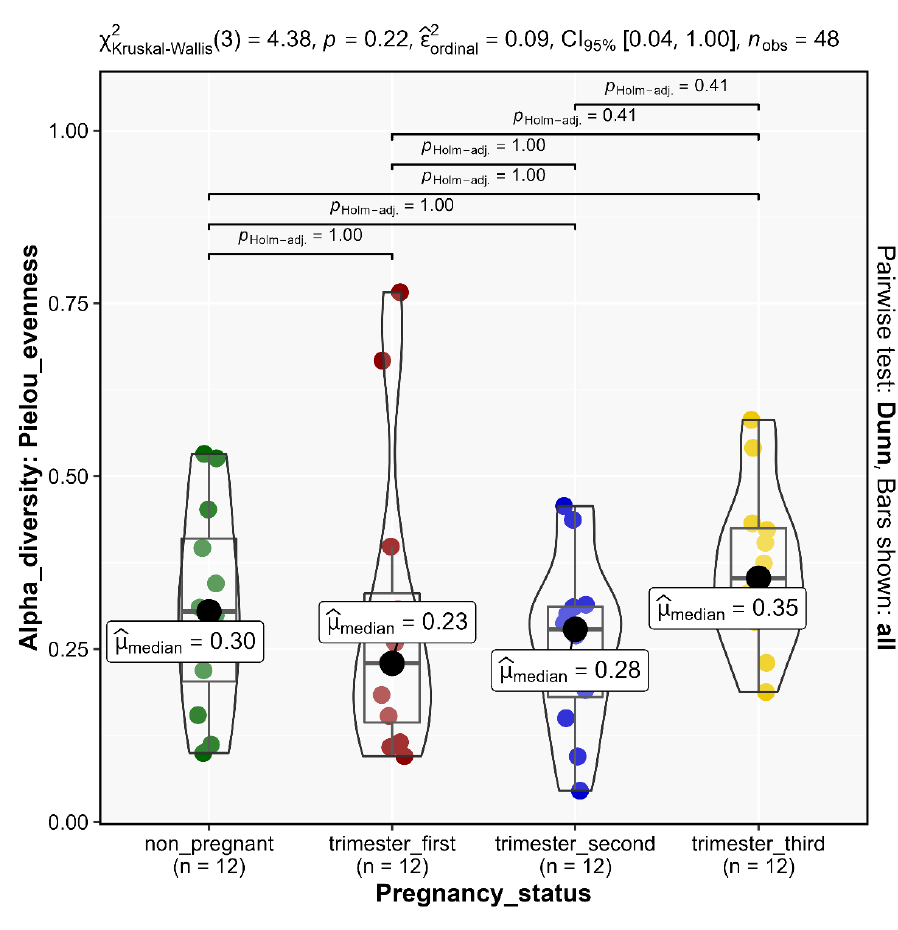
Figure 4. Pielou’s evenness Alpha diversity of vaginal microbial communities across the three trimesters of pregnancy in comparison to non-pregnant state. Holm-adjusted p values were used to indicate significance. Dunn pairwise test was performed.